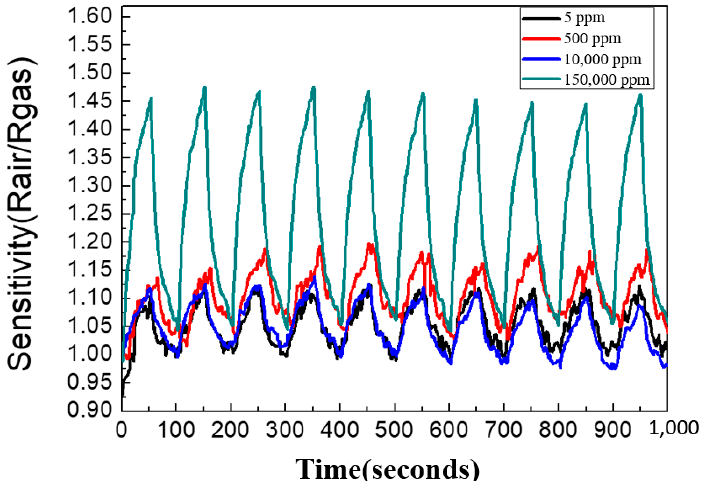
Figure 9. The reproducibility test of the graphene/zinc oxide nano-heterostructure at 250 °C with different H 2 concentrations.